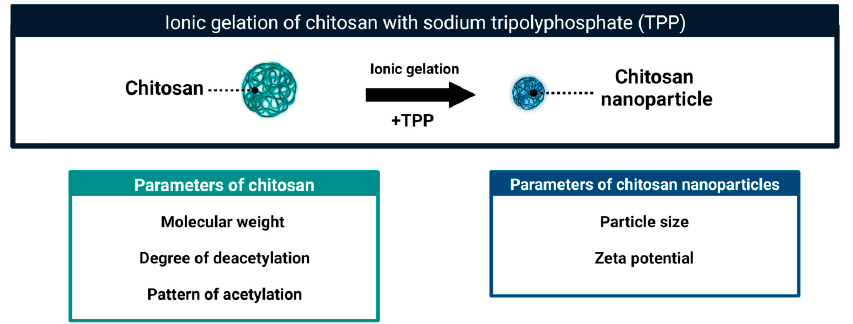
Figure 5. Schematic representation of the formation of chitosan nanoparticles and their basic param- eters.